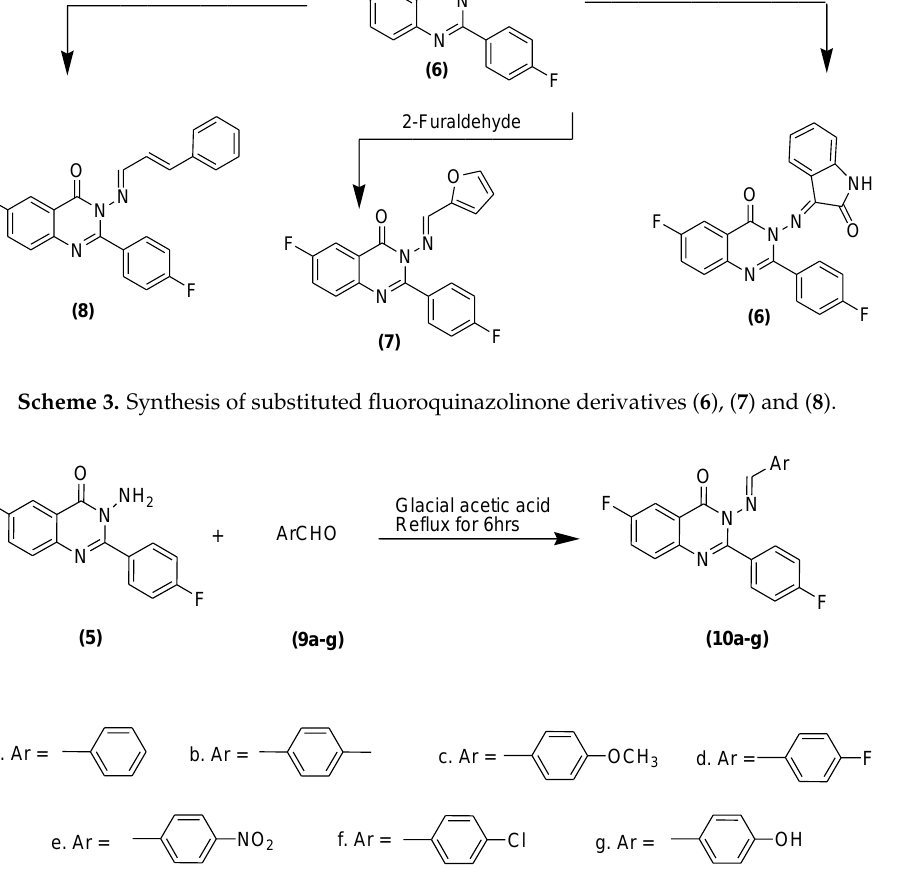
Scheme 4. Synthesis of substituted fluoroquinazolinone derivatives ( 10a – g ).